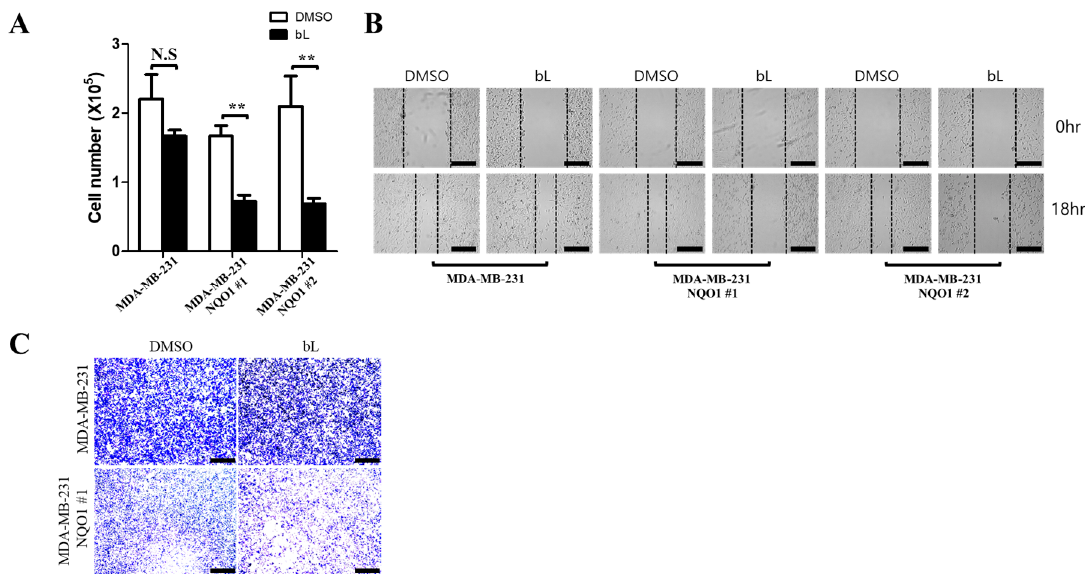
Figure 4. The bL compound suppresses cell proliferation and migration in an NQO1-dependent manner. ( A ) Cell proliferation was determined by counting the cell numbers of MDA-MB-231 and two independent clones of NQO1 stable cells (NQO1 #1 and #2) after treatment with bL (2 μ M) for 24 h. The data are presented as means ± SEM; n = 3; ** p < 0.01, N.S: not significant. ( B ) A wound healing assay was performed as described in Section 4, using MDA-MB-231 and two independent clones of NQO1 stable cells (NQO1 #1 and #2) treated with bL (2 μ M) for 18 h. Images were taken using a new hybrid microscope (Echo, San Diego, CA, USA). The scale bar is 230 μ m. The black dash line indicates boundary that cells migrate. ( C ) A cell migration assay was performed with Transwell cell culture chambers as described in Section 4, using MDA-MB-231 and NQO1 stable cells treated with bL (2 µ M) for 7 h. Images were taken using a new hybrid microscope (Echo, San Diego, CA, USA). The scale bar